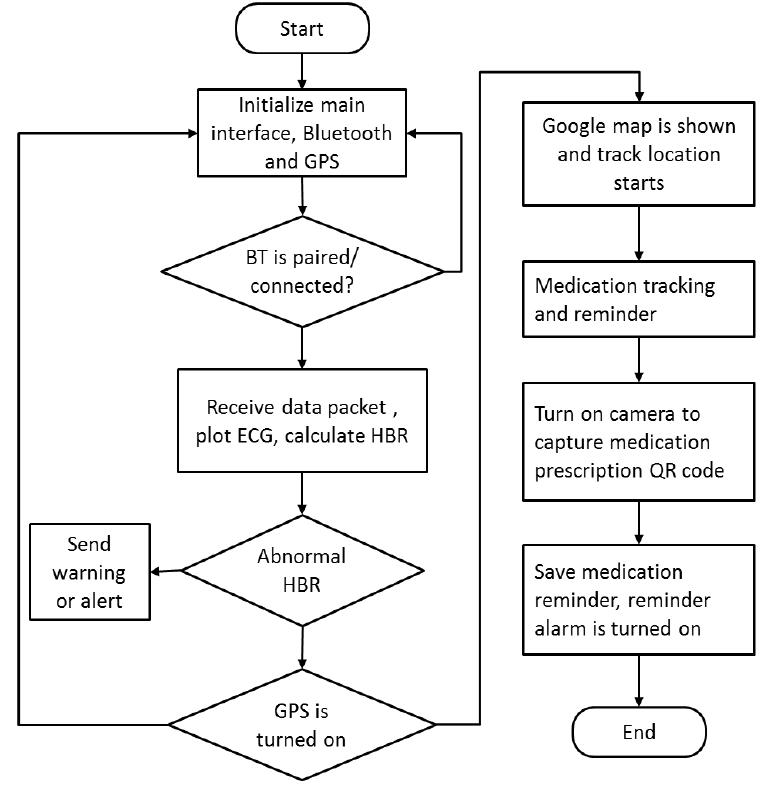
Figure 7. Flowchart of mobile application for health status real-time monitoring and personalized life